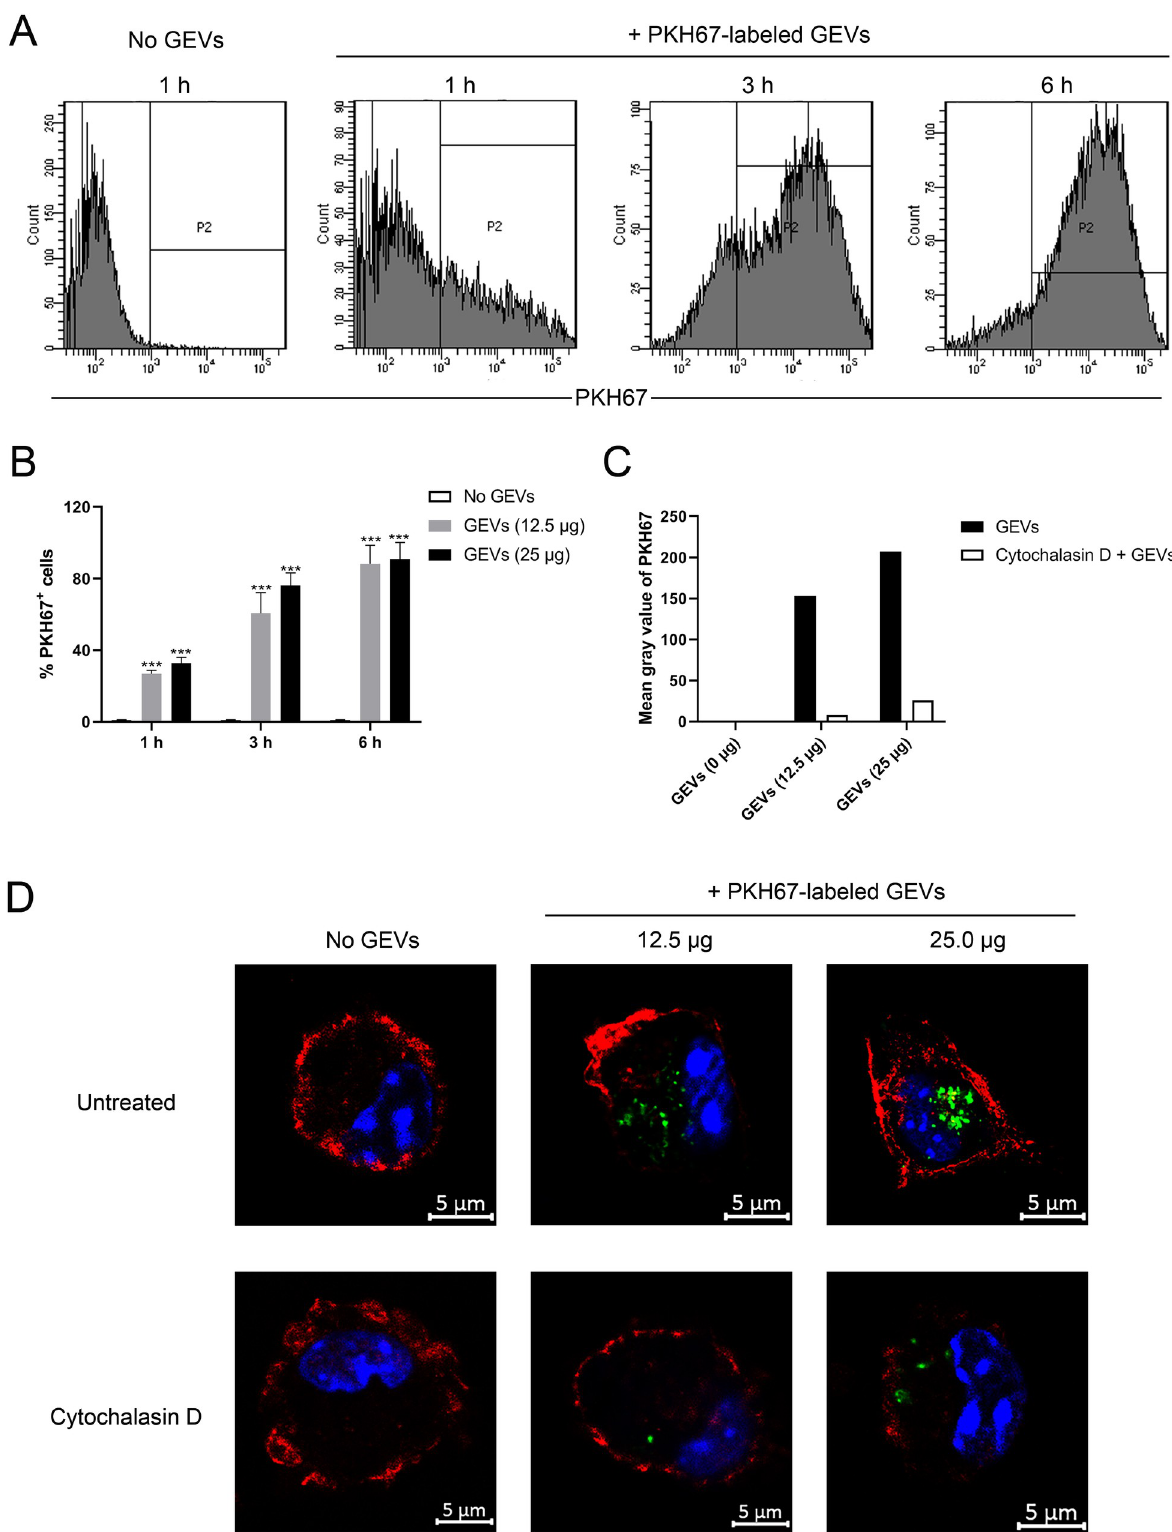
Fig 2. GEVs are actively captured by murine peritoneal macrophages. (A) Twenty-five microgram of GEVs were inoculated into murine peritoneal macrophages, incubated for time periods of 1, 3 and 6 h, and detected through flow cytometry. (B) Different doses of GEVs (25 μ g